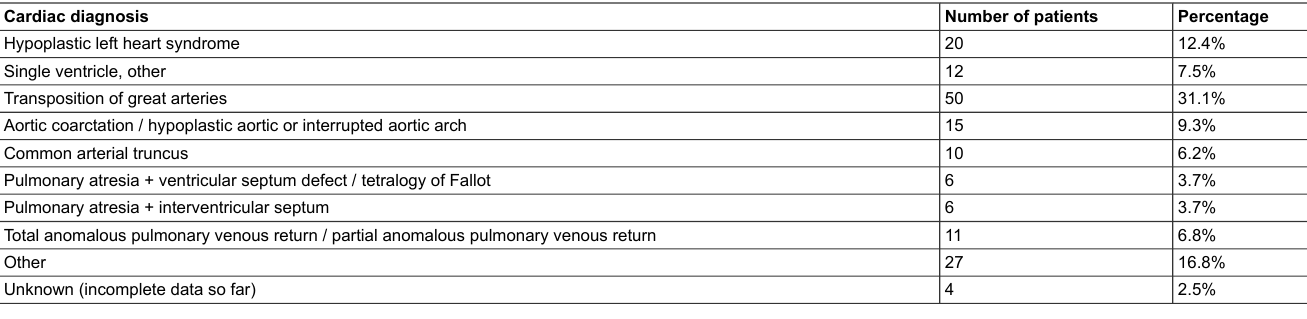
Table 5: Preliminary data 2019-2021. Cardiac